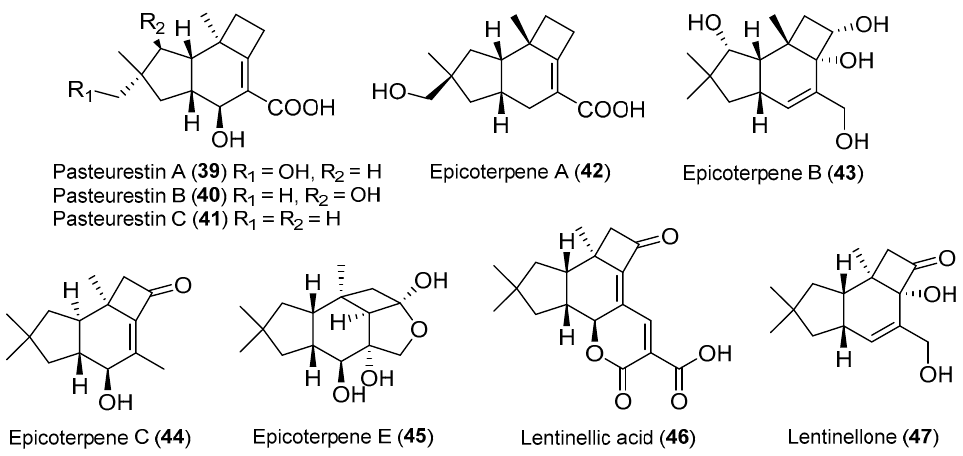
Figure 9. Structures of protoilludanes 39 – 47.